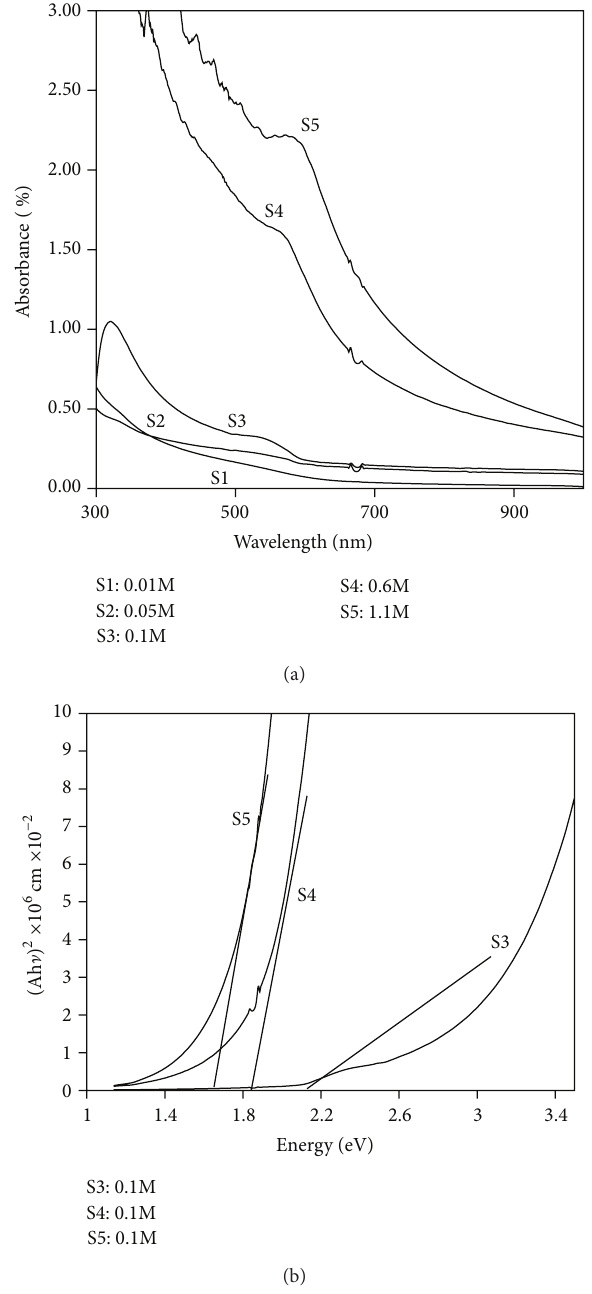
Figure 1: (a) UV-Vis absorption spectra of CdSe/PVA nanocom- posite thin films (S1, S2, S3, S4, and S5) prepared by thermolysis at 300 ∘ C. (b) Bandgap calculation of CdSe/PVA nanocomposite thin films (S3, S4, and S5) prepared by thermolysis at 300 ∘ C.